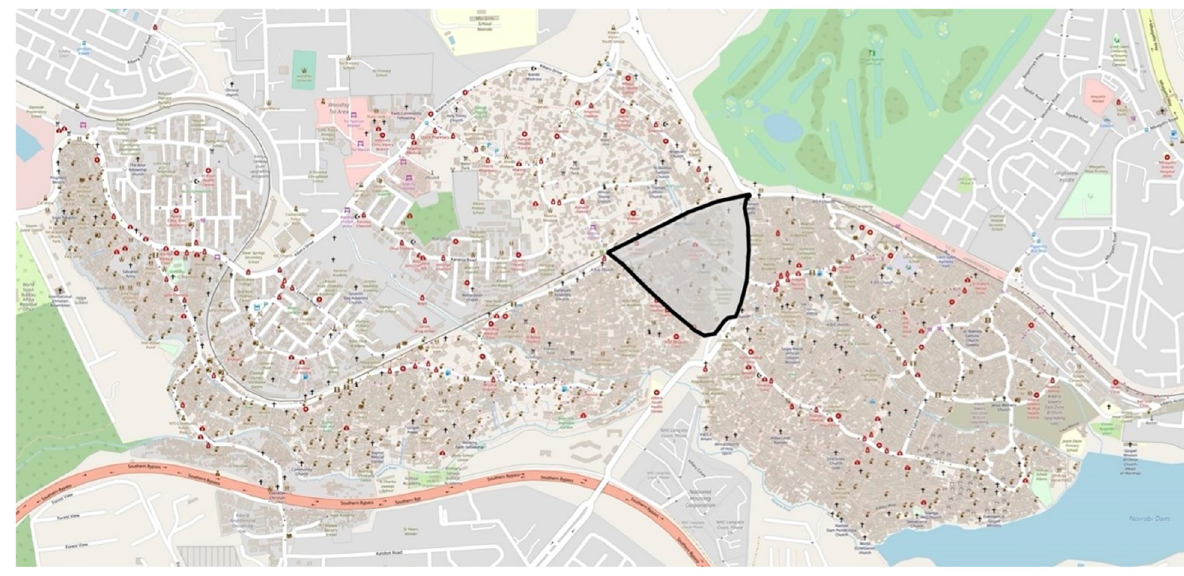
Fig 1. The catchment area of the research within